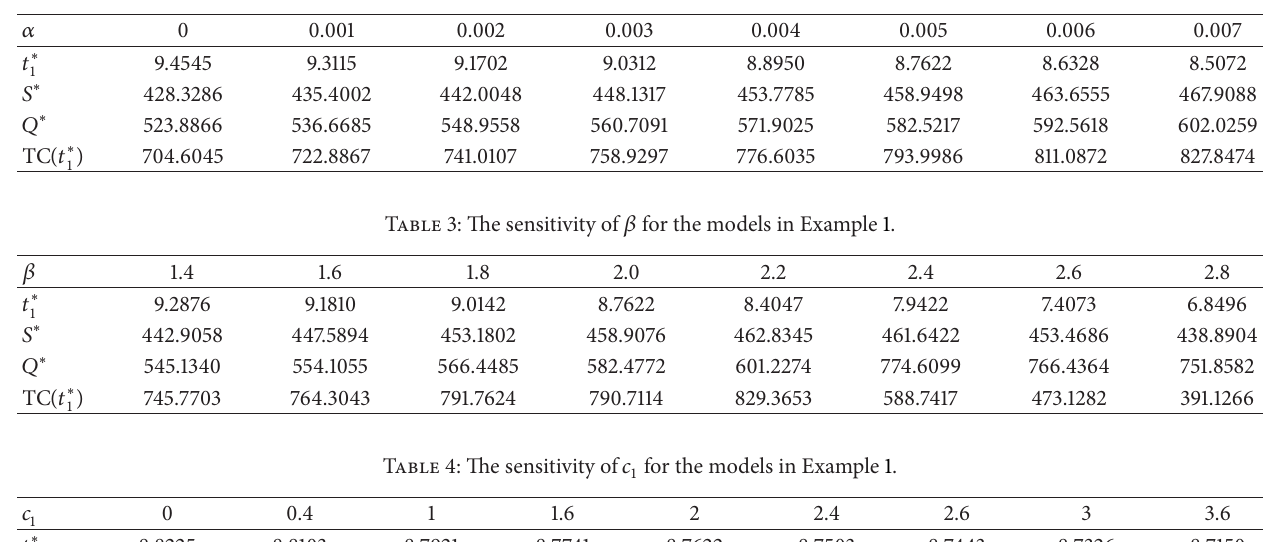
Table 2: The sensitivity of 𝛼 for the models in Example 1.